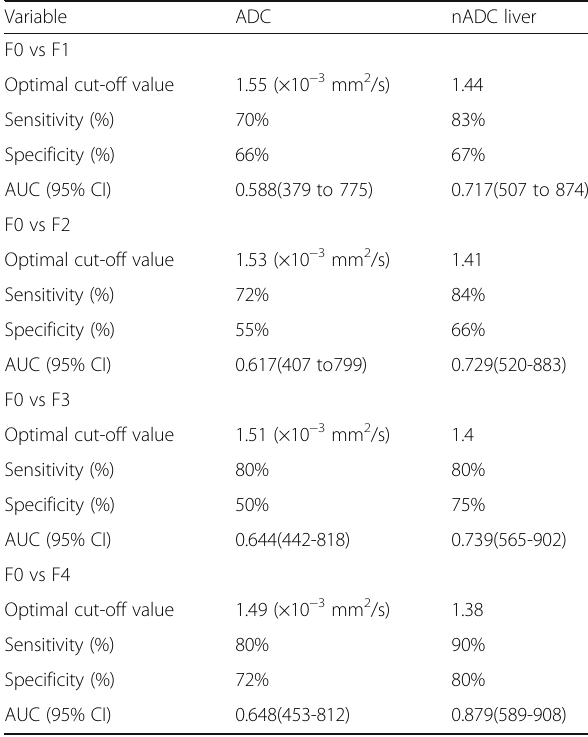
Table 5 The optimal cut-off values of nADC liver and ADC for each fibrosis